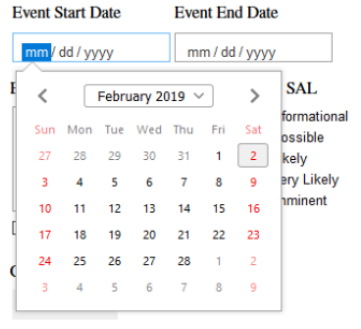
Figure A2. Selecting event start and end dates in the interface.